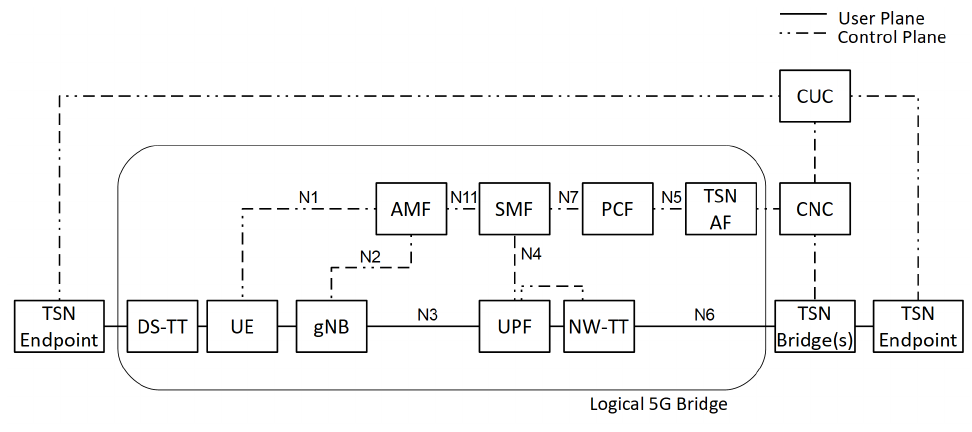
Figure 2. Integration Architecture of 5G as a TSN